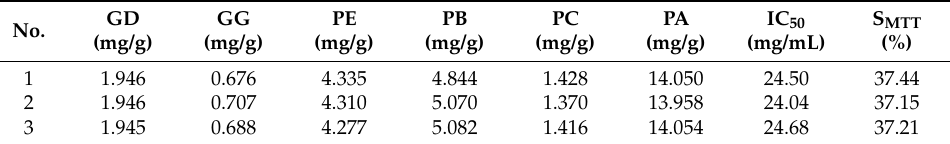
Table 6. The results of verification of predictive model.